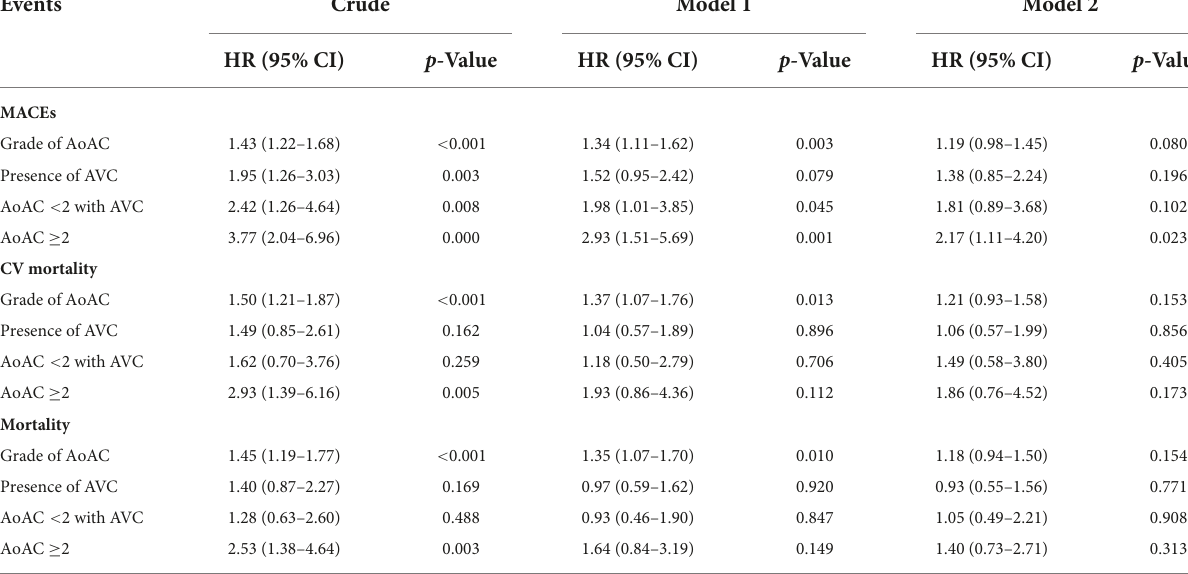
TABLE 3 Cox proportional hazard analysis of outcome events in patients on MHD according to the severity of AoAC with and without AVC.